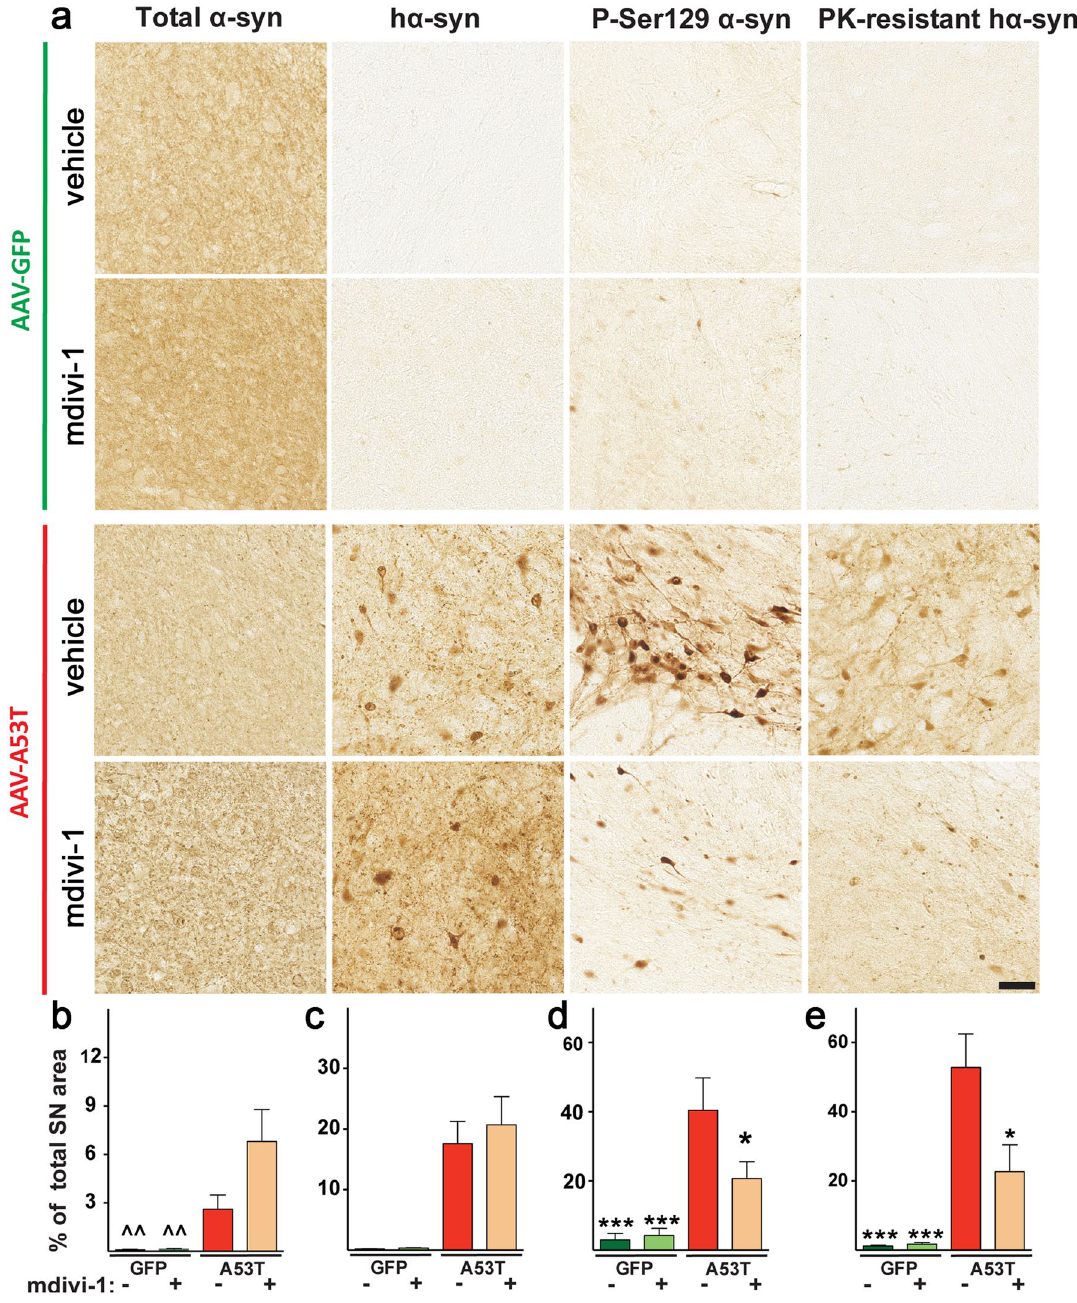
Figure 3. Mdivi-1-mediated neuroprotection is accompanied by a decrease in phospho- and PK-resistant α -syn. ( a ) Representative pictures of α -syn immuno-staining in SN of AAV-hA53T- α -syn and AAV-GFP transduced rats. From left to right: total (endogenous rat α -syn + human A53T- α -syn), human A53T, phosphorylated and PK-resistant A53T α -syn. Scale bar 50 μ m. ( b ) When quantified, the expression of total α -syn is higher in rats injected with hA53T- α -syn and increases further after mdivi-1 treatment, suggesting mdivi-1 preserved more dopaminergic structures. ( c ) As expected, higher levels of human α -syn were detectable in animals with hA53T- α -syn transduction. Mdivi-1 did not affect the total levels of this protein. ( d ) The level of phosphorylated α -syn was increased in A53T animals and, mdivi-1 treatment attenuated this upregulation. ( e ) Following PK treatment, a strong hA53T- α -syn immunoreactivity persisted in A53T animals. This signal was significantly reduced in A53T rats treated with mdivi-1. The quantification was carried out using an automated threshold in one slice per animal. Values are means ± SEM for 7–8 animals analysed by two-way ANOVA ( b ) AAV injection: F 1,27 = 16.68 p < 0.001; treatment: F 1,27 = 3.611 p = 0.0681; AAV injection x treatment: F 1,27 = 3.476 p = 0.0732; ( d ) AAV injection: F 1,27 = 22.69 p < 0.001; treatment: F 1,27 = 3.176 p = 0.0859; AAV injection x treatment: F 1,27 = 4.066 p = 0.0538; e , AAV injection: F 1,27 = 31.45 p < 0.001; treatment: F 1,27 = 5.217 p = 0.0305; AAV injection x treatment: F 1,27 = 5.635 p = 0.025) followed by Tukey multiple comparison test ( * p < 0.05; *** p < 0.001 to A53T vehicle, ^^p < 0.01 to A53T